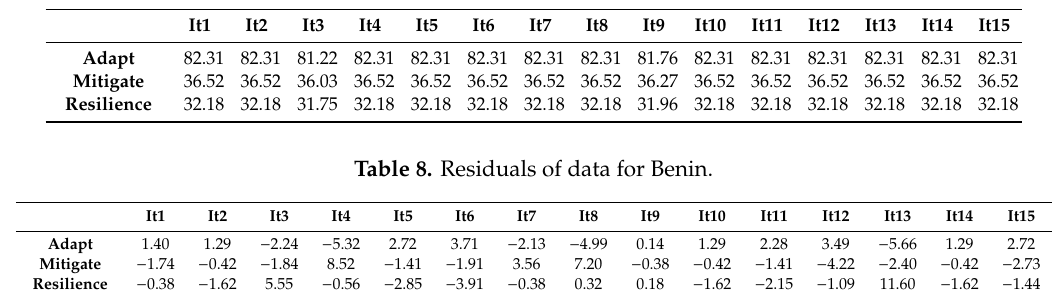
Table 7. Expected counts of data for Benin.